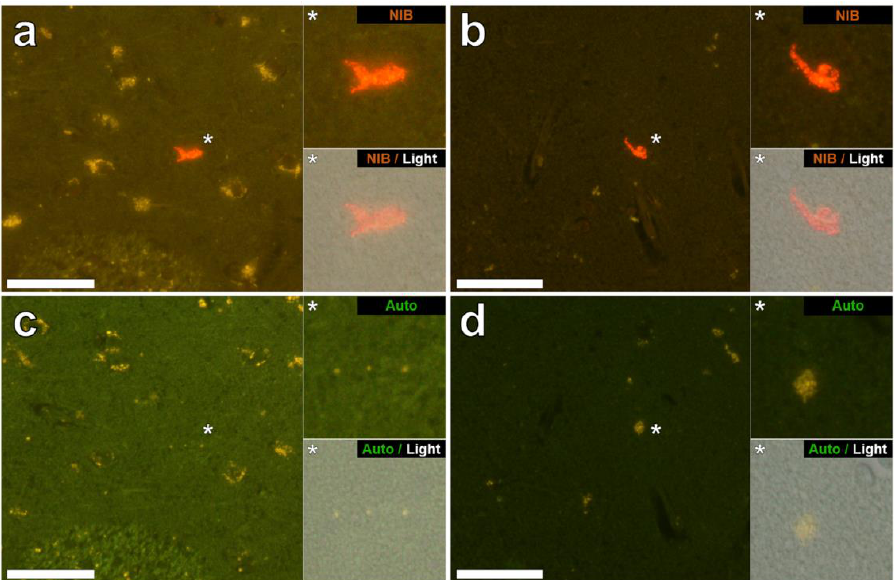
Figure 2. Intracellular aluminium in glia observed in the temporal lobe and hippocampus of a 56-year-old male donor (MS274), diagnosed with RRMS. Bright orange fluorescence was observed intracellularly and co-deposited within the cellular debris of occasional cells morphologically compatible with glial cells in ( a ) the internal capsule and ( b ) the hippocampus (both grey matter). Autofluorescence of serial sections ( c , d ) confirms the identity of aluminium in ( a,b ) respectively. Upper and lower panels depict magnified inserts of the fluorescence channel and bright field overlay. Magnification ×400, scale bars: 50 μm.